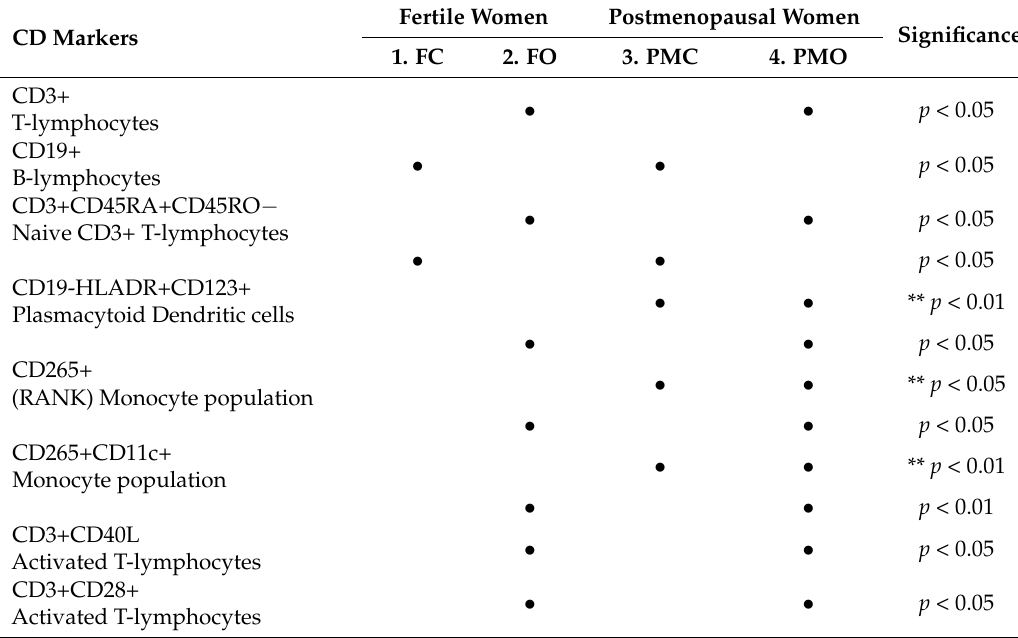
Table 2. Comparison of cell surface receptors and cell populations in whole blood samples from fertile and postmenopausal women. Fertile